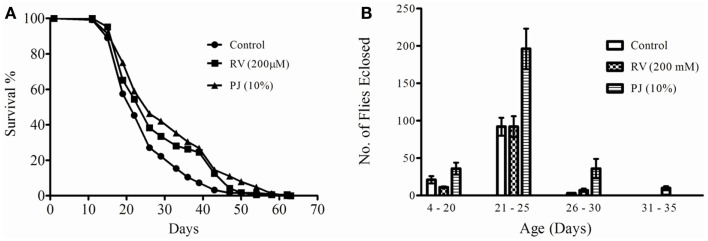
(A). Effect of pomegranate juice supplementation on Drosophila longevity. Male and female mixed culture flies were fed with 10% PJ (n = 164) or 200 μM RV (n = 167). A basal medium control (n = 247) was also maintained. Log rank test indicated significant (p < 0.00001) increase in the fly survival by both PJ and RV (Table 1). But PJ increased the median survival by 19.23% while it was 11.05% in the RV group. (B) Effect of 10% pomegranate juice supplementation on Drosophila fecundity at different age. The bars represent the total number of flies enclosed from each group at different age with SD. PJ group showed significant increase in the number of off-springs produced (*p < 0.0001). The graph also indicates an extended reproductively viable phase in the PJ fed flies. No significant difference in fecundity was observed with RV and control groups.